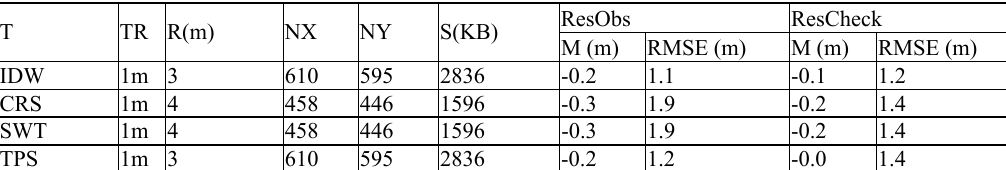
Table 6. Characteristics of the grids interpolated from TR1 with accuracy similar to DTM MR . T: technique used to interpolate; R: spatial resolution; NX and NY: number of nodes in X and Y; S: storage size; ResObs, ResCheck: statistics of the residual on the used observations and the check points; M: mean; RMSE: root mean square